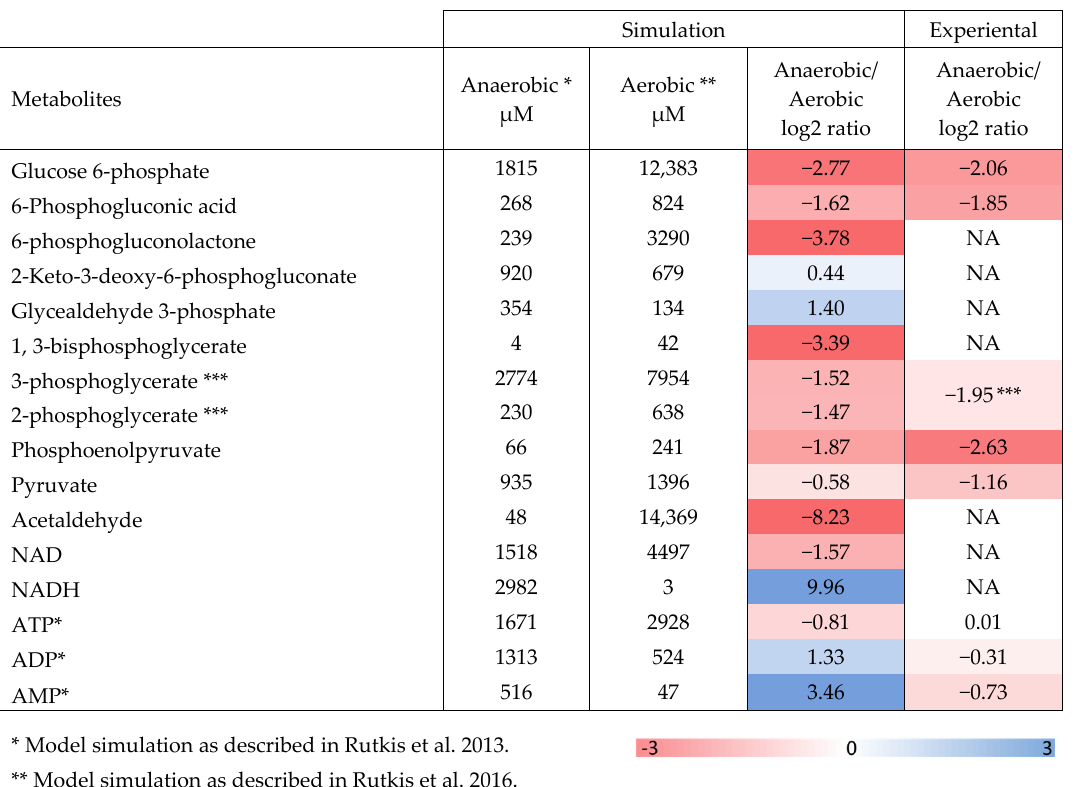
Figure 2. In silico simulation of ED intermediate pools in resting Z. mobilis cells and comparison to the experimental data. The simulation was conducted employing ED pathway kinetic model in non-growing Z. mobilis as described in [8,27].